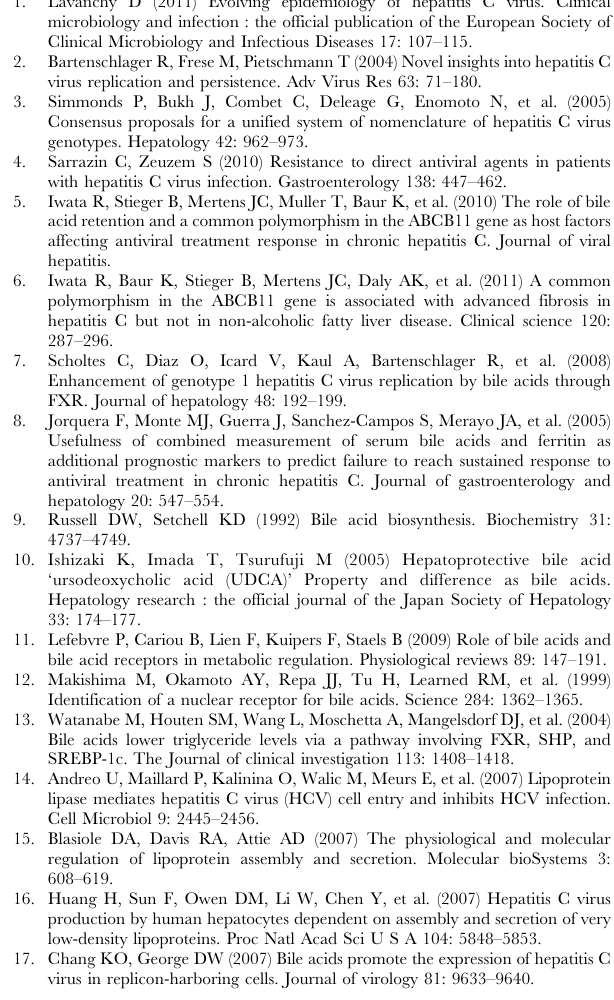
Figure S2 Influence of bile acids on HCV in transfected Huh7-LunetN # 3 cells. A: Huh7-LunetN # 3 cells lacking CD81 were transfected with Luc-Jc1. A: Replication efficiency was determined as described in Fig. 2 B: 48 h after transfection culture fluid was collected and used to inoculate Lunet G-luc cells. Luciferase activity was determined 48 h later. Figure S3 Influence of bile acids on HCV entry. A–C: HCV GT2a pseudoparticles ( A ), VSV-G pseudoparticles ( B ) MLV pseudoparticles ( C ) or HCV TCP ( D ) were used to inoculate Lunet G-luc cells pre-incubated for 24 h or 48 h with indicated